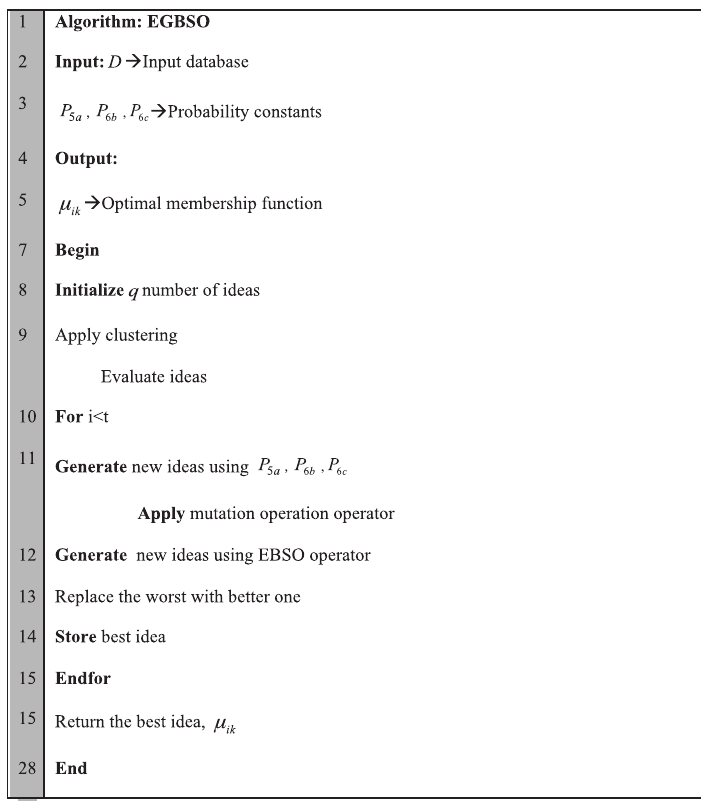
Figure 3: Pseudo Code of the EGBSO